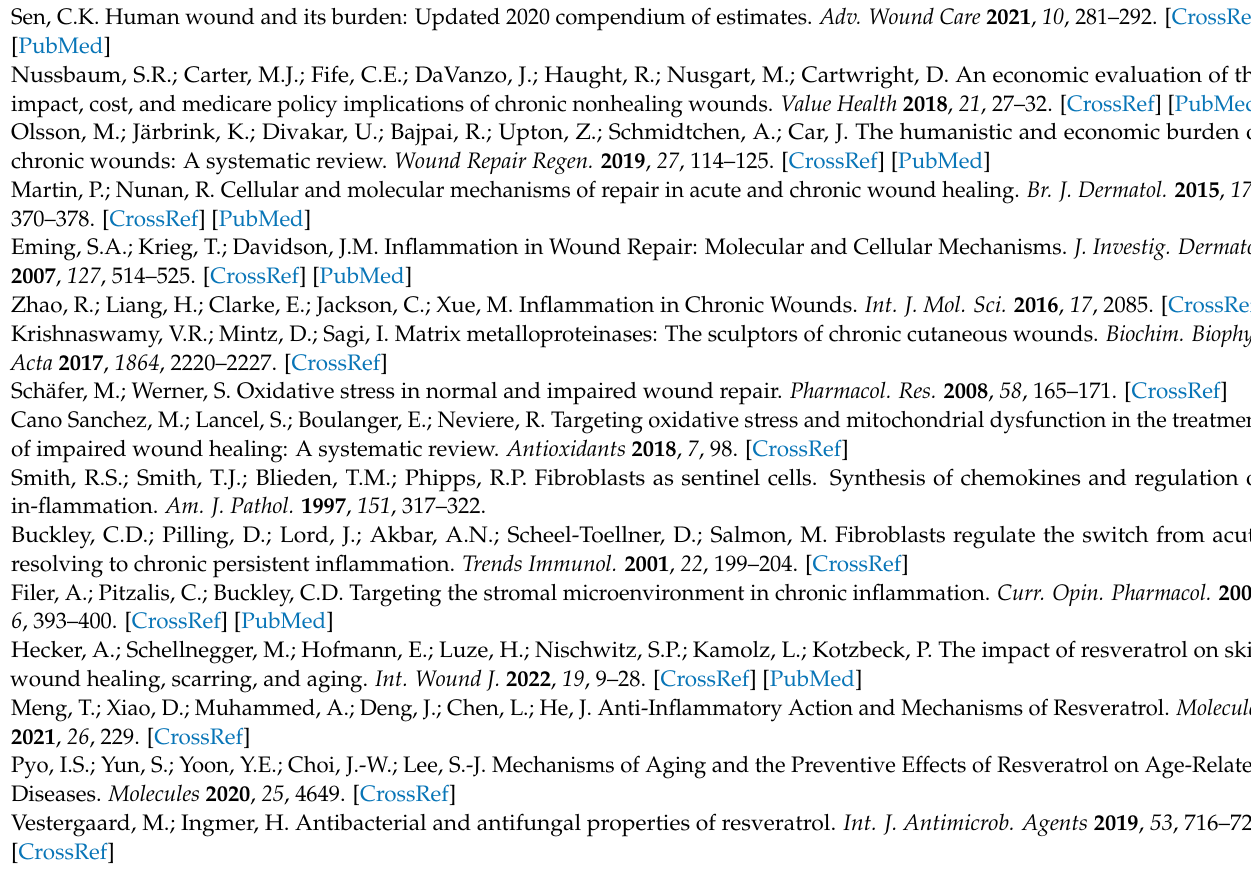
Table S2: Detailed statistical analysis of gene expression